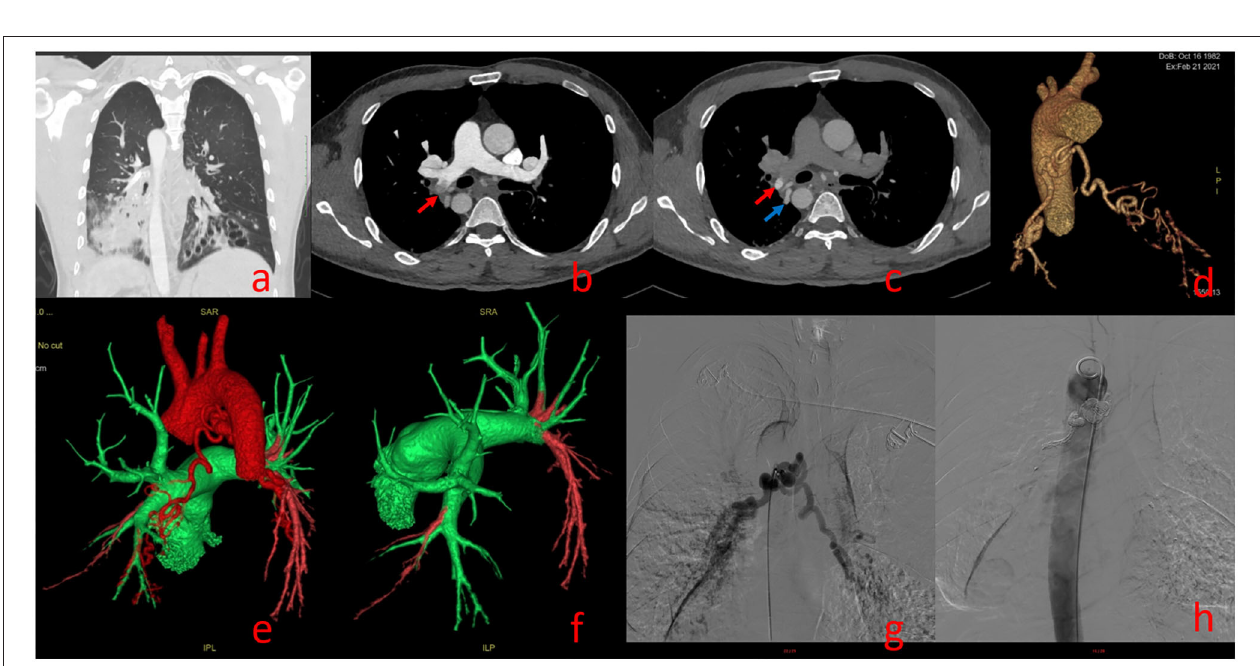
FIGURE 3 | Pulmonary insufficiency artifacts (PIA, Supplementary Video 5 ). A 39-year-old woman with pulmonary hypertension underwent dual phase-computed tomography pulmonary angiography. A strip filling defect can be seen in the superior lingular branch of left pulmonary artery (SLBLPA), as shown by the arrow in (a) (pulmonary artery phase); SLBLPA is well displayed, and there is no filling defect in (b) (aortic phase); (c) Pulmonary angiography confirmed that there was no PE in SLBLPA.